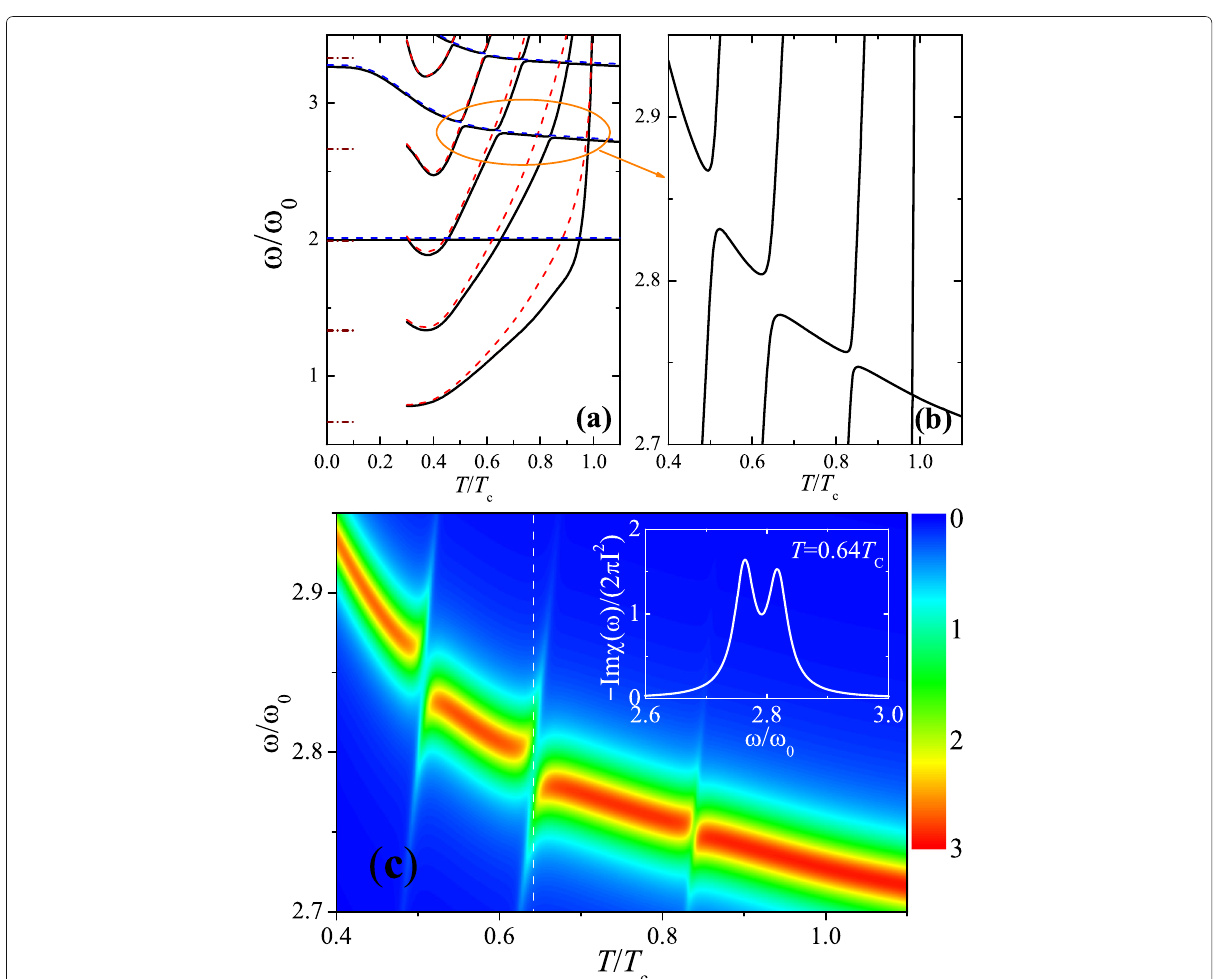
Fig. 5 a Two-fluid modes of a unitary Fermi gas in an isotropic harmonic trap. The full solutions of the two-fluid equations are given by the solid lines. The first sound modes (blue dashed lines) given by Eq. (16) are shown along with the second sound modes (red dotted lines) given by Eq. (17). The dashed lines at T = 0 show the analytic results for the second sound frequency. b A blow-up of part of the left panel showing the hybridization between second sound and the n = 1 first sound mode. c The two-dimensional contour plot of the density response Im χ(ω) in the vicinity of the n = 1 first sound mode. The delta functions in Im χ(ω) have been broadened by 0.02 ω 0 for visibility. The inset shows a double peak structure at the hybridization point T (cid:3) 0.64 T c . Adapted from Ref.